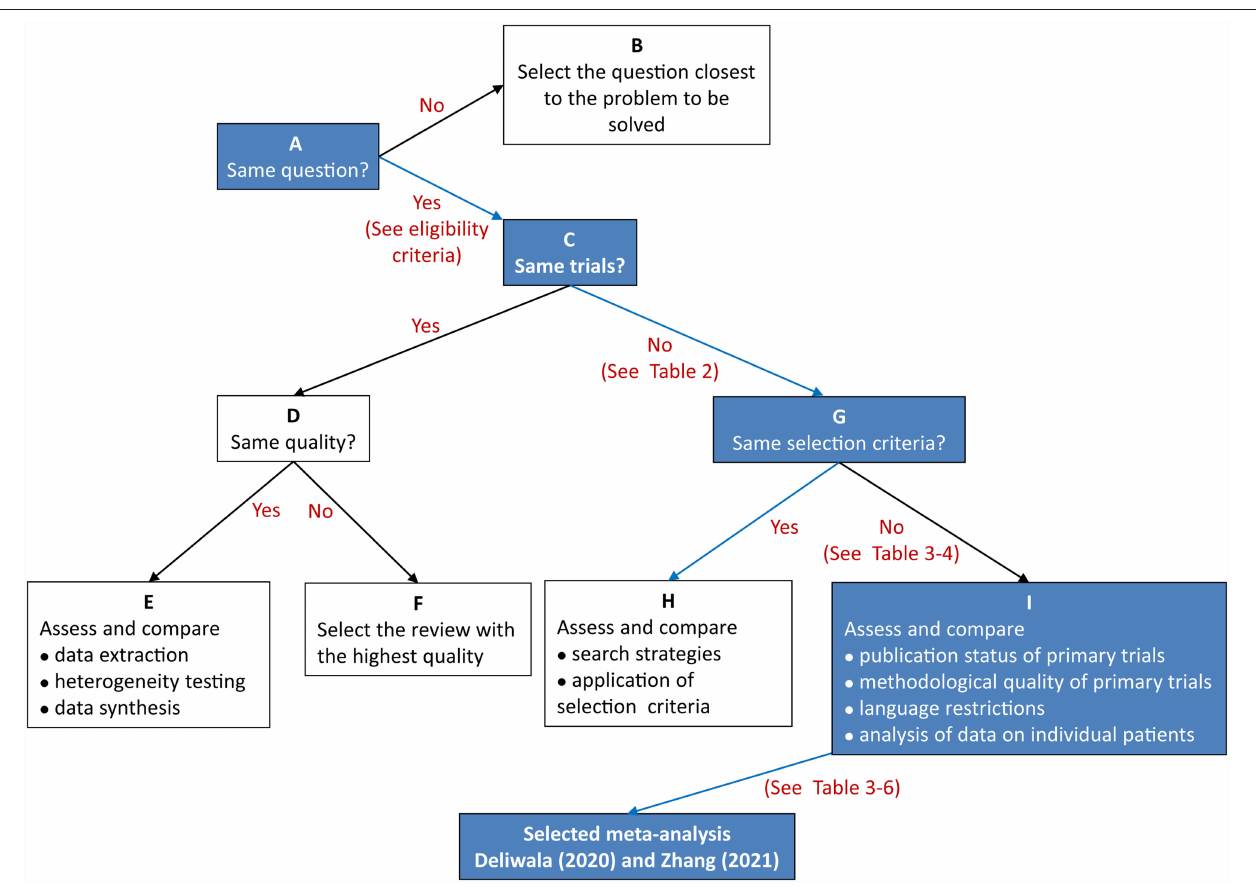
FIGURE 2 | Flow diagram of Jadad decision